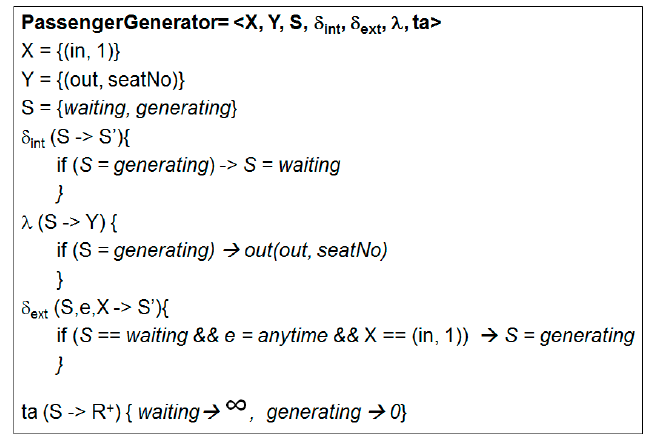
Figure 3. Passenger generator DEVS specification.